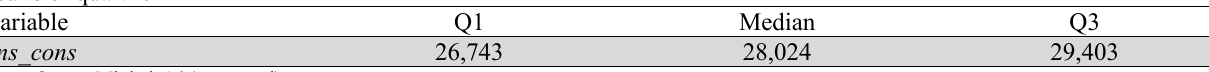
Results of quartile Variable